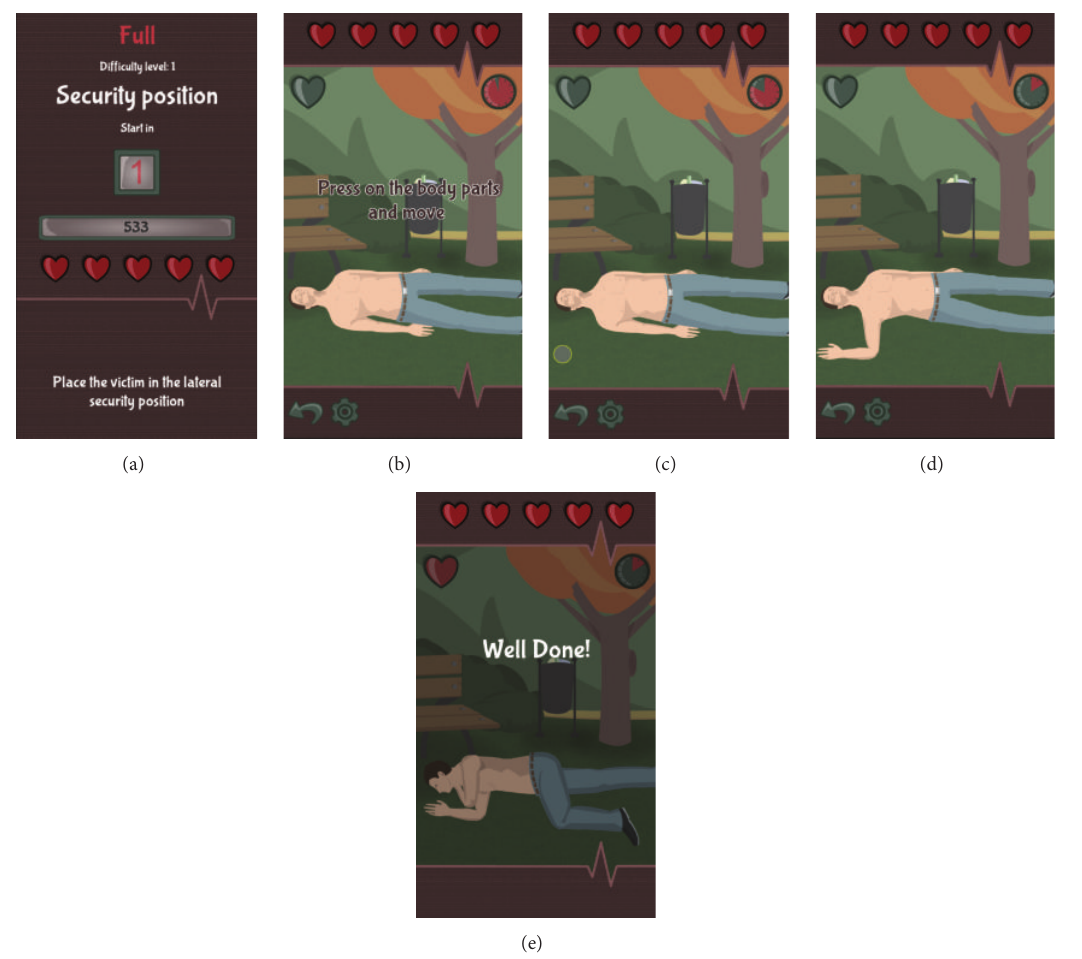
Figure 11: Game screens corresponding to the Security Position mini game. (a) The main scene. (b) The icon that appears to move the arm. (c) After moving the arm. (d) The victim in the lateral security